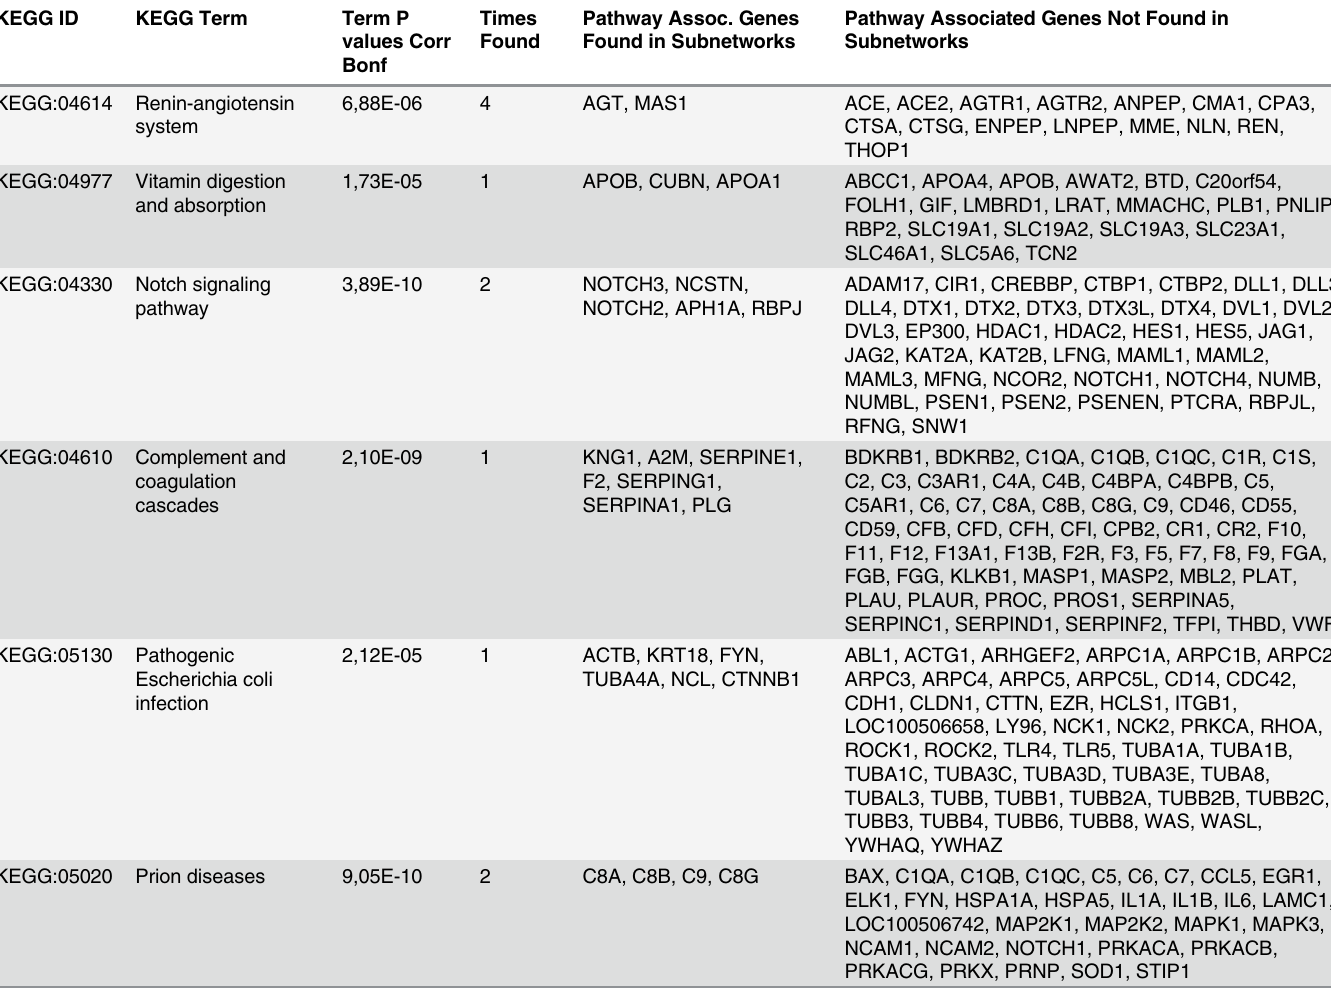
Table 3. Molecular pathways and associated proteins in RRMS